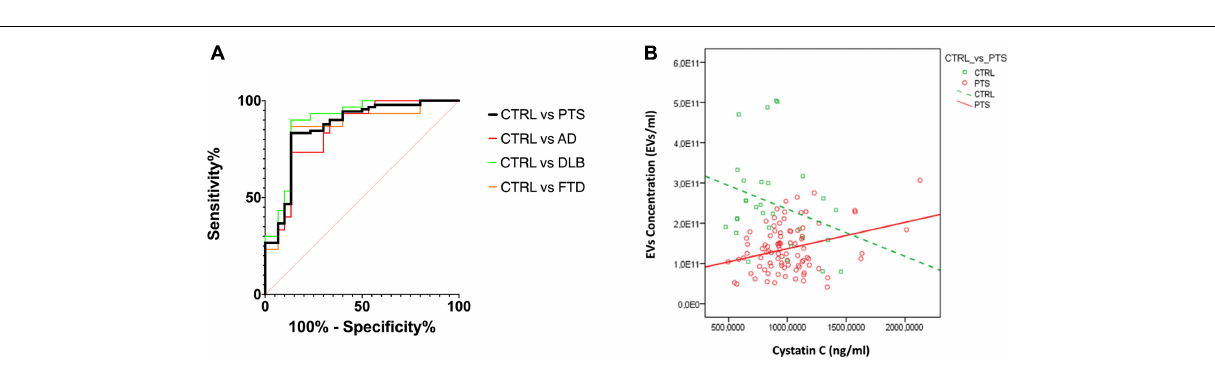
FIGURE 3 | (A) ROC curves for EVs concentration/size. The ratio of EVs concentration/size was used to evaluate the discrimination of PTS from CTRL; AUC CTRL vs. PTS 0.86 (black); CTRL vs. AD 0.84 (red); CTRL vs. DLB 0.89 (green); CTRL vs. FTD 0.84 (orange); AUC comparison with DeLong test, p > 0.436. (B) CysC levels and EVs concentration are negatively/positively associated with CTRL/PTS, respectively (std beta = –0.28; std beta = 0.31 respectively). CTRL, controls (green); PTS, patients